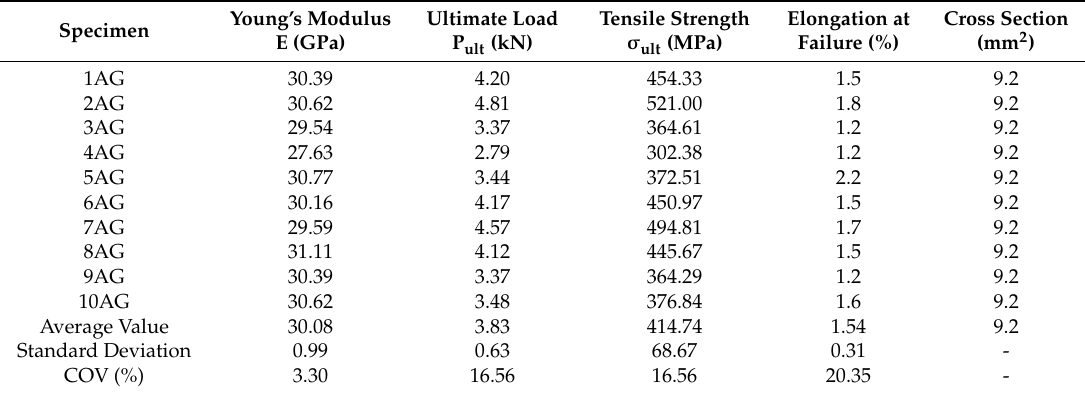
Table 4. Tensile tests results for aged specimens in alkaline bath.